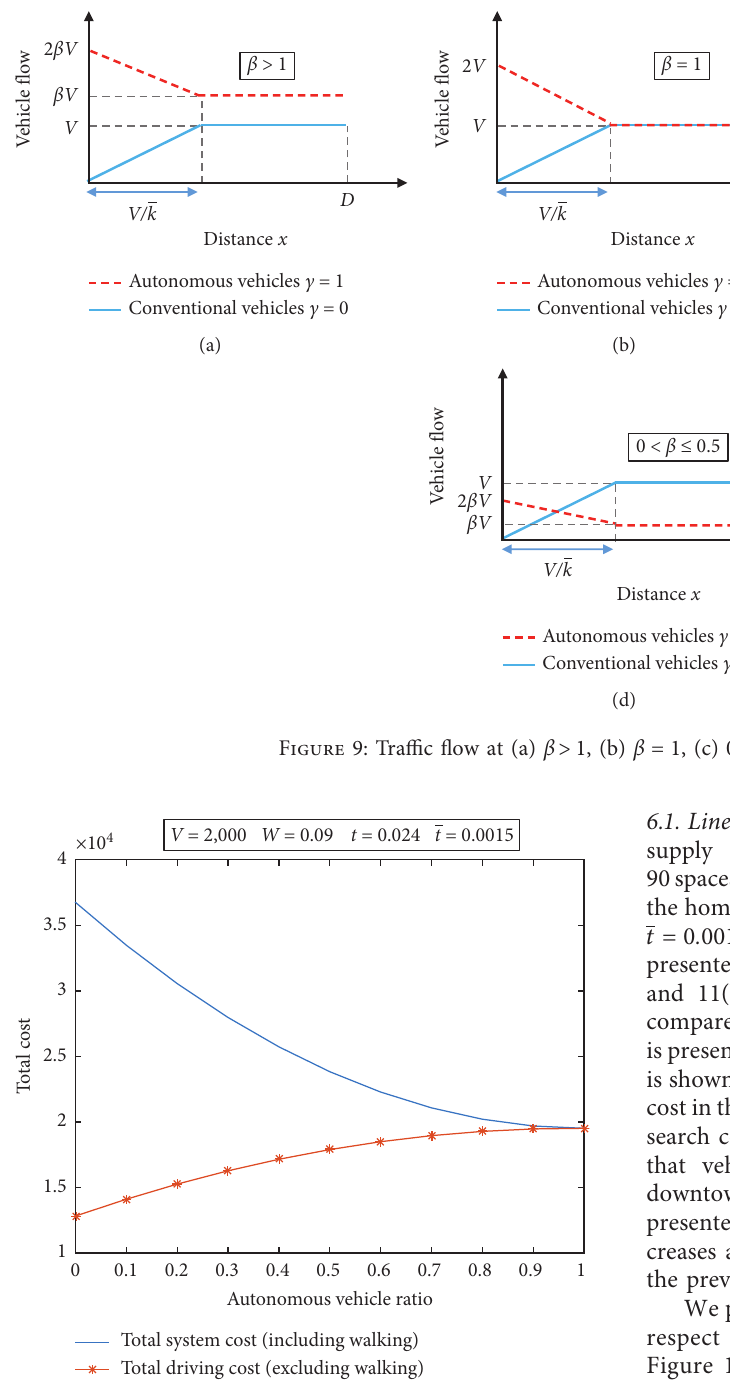
Figure 10: Total system cost and driving cost at different AV penetration